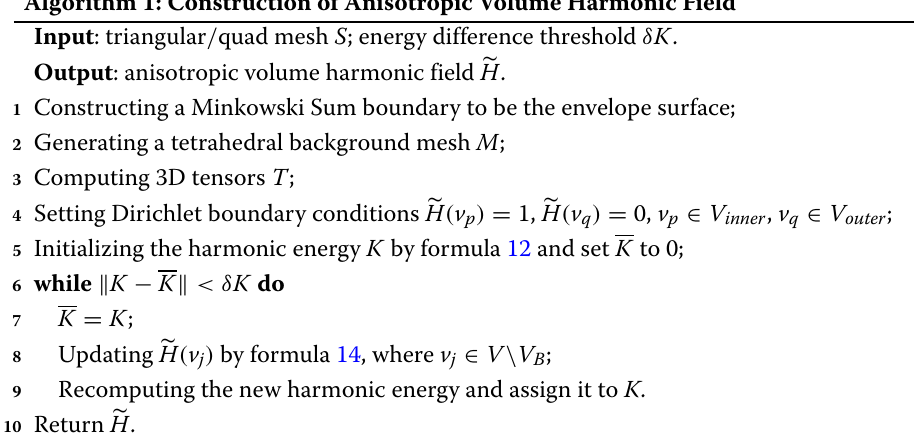
Algorithm 1: Construction of Anisotropic Volume Harmonic